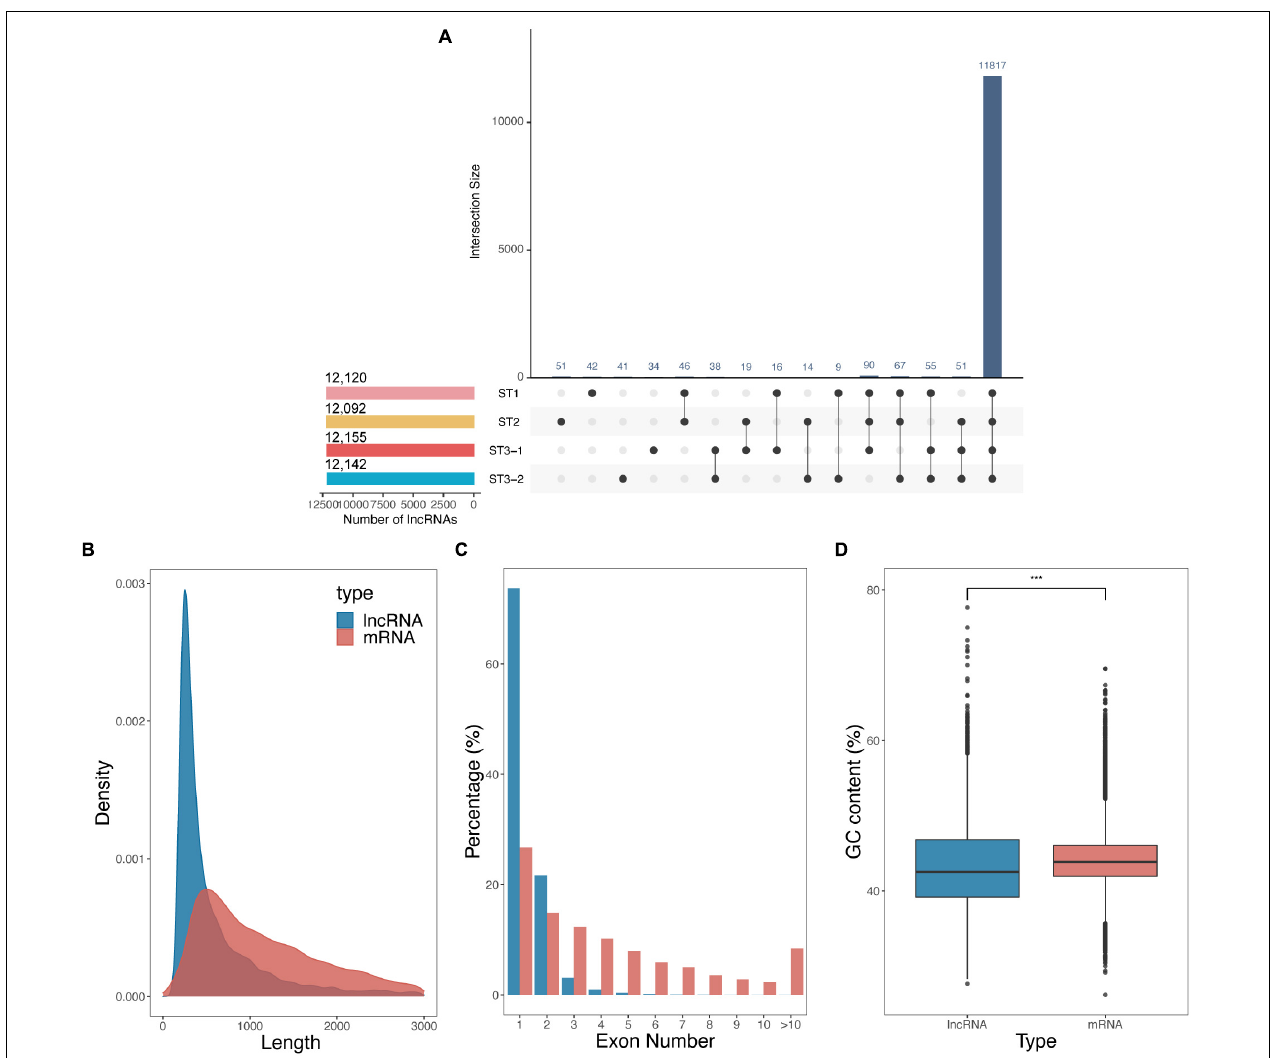
FIGURE 3 | Characteristics of long non-coding RNAs (lncRNAs) during the early differentiation of female strobilus buds in ginkgo. (A) The UpsetR plot shows the number of lncRNAs identified from each stage, i.e., the vegetative (ST1), the initial differentiation (ST2), and the exuberant differentiation stages (ST3-1 and ST3-2). (B–D) Comparisons of lncRNAs and mRNAs with respect to the transcript length, exon number, and GC content.